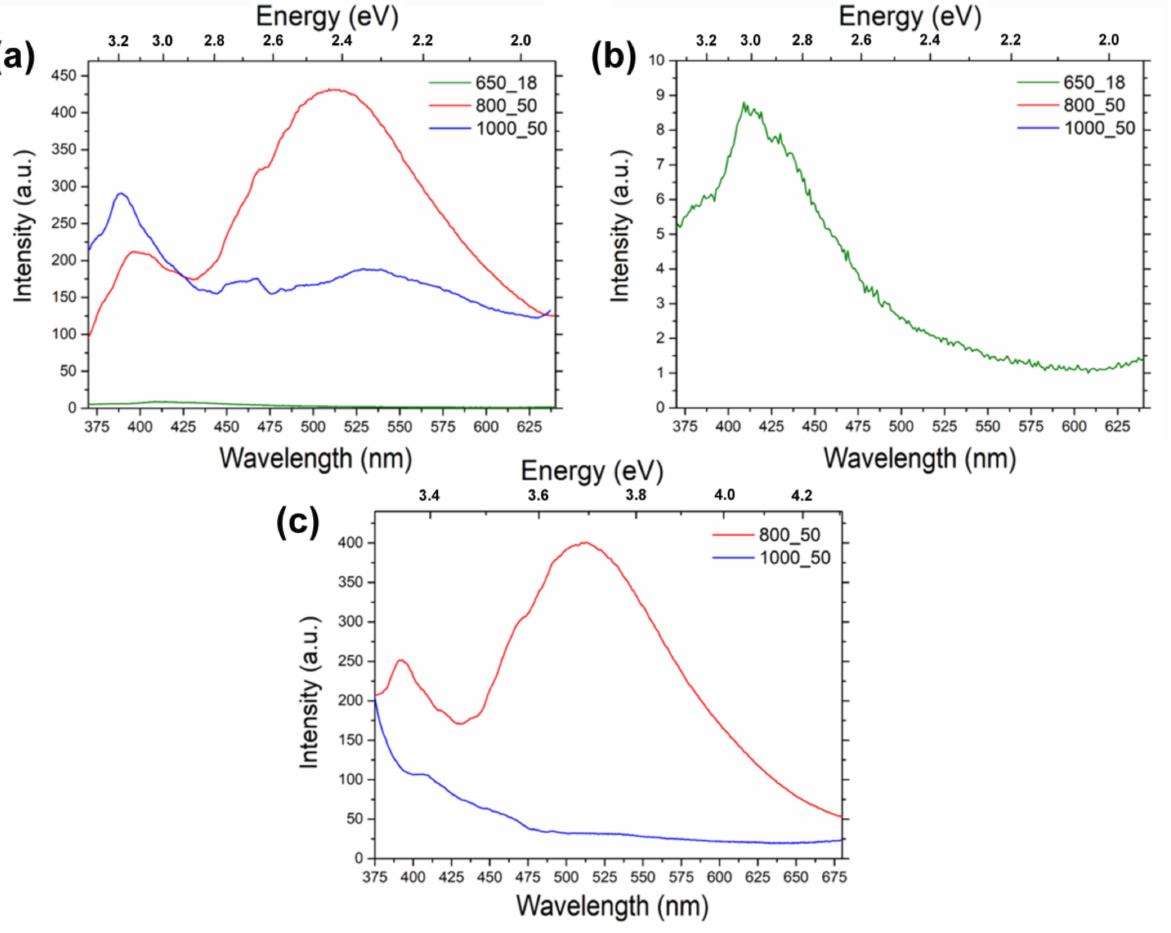
Figure 10. The photoluminescence of: ( a ) all samples measured with a 330 nm excitation; ( b ) sample 650_18 measured with a 330 nm excitation; ( c ) samples 800_50 and 1000_50 measured with a 355 nm